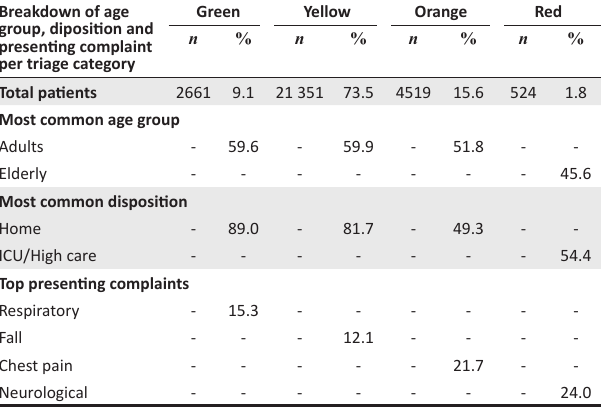
TABLE 2: Triage category allocations for age, disposition and presenting complaints in a private emergency centre in Pretoria in 2018.